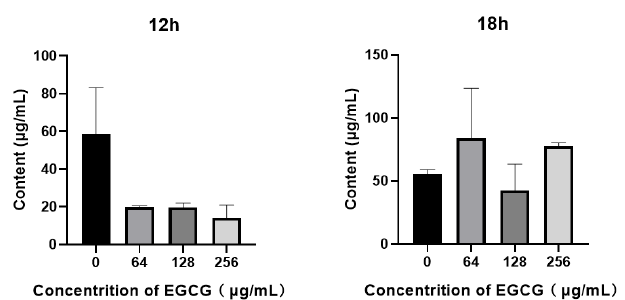
Figure 8. The inhibitory effect of EGCG on the production of rhamnolipid in P. aeruginosa. (All the data are representative of three independent experiments performed in triplicate and expressed as the mean ± SD values in each bar.